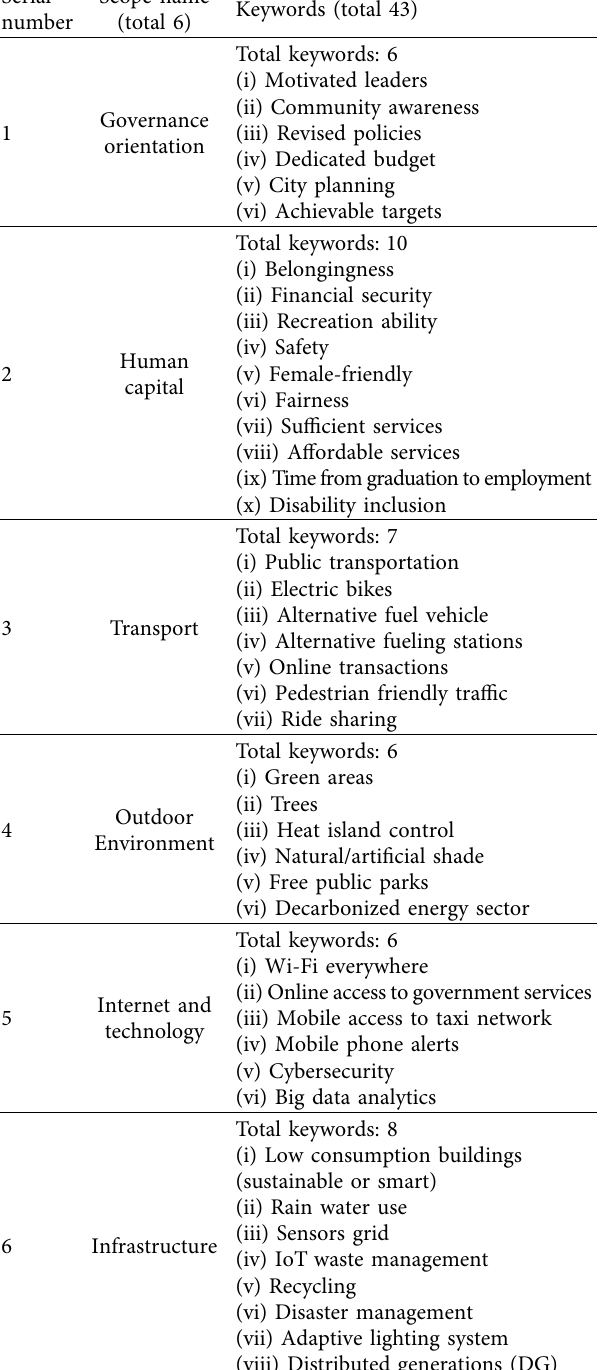
Table 2: Suggested scopes of a smart